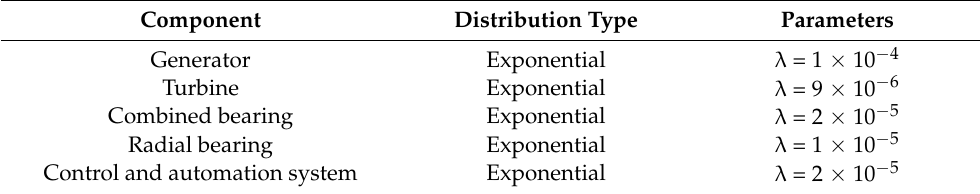
Table 1. Parameter values of the mean time between failures (MTBF) distributions of the considered components.